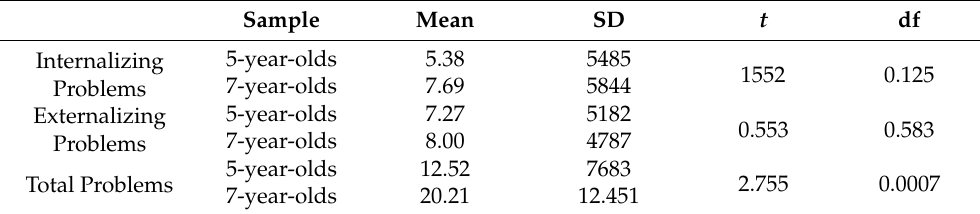
Table 4. Paired samples t -test